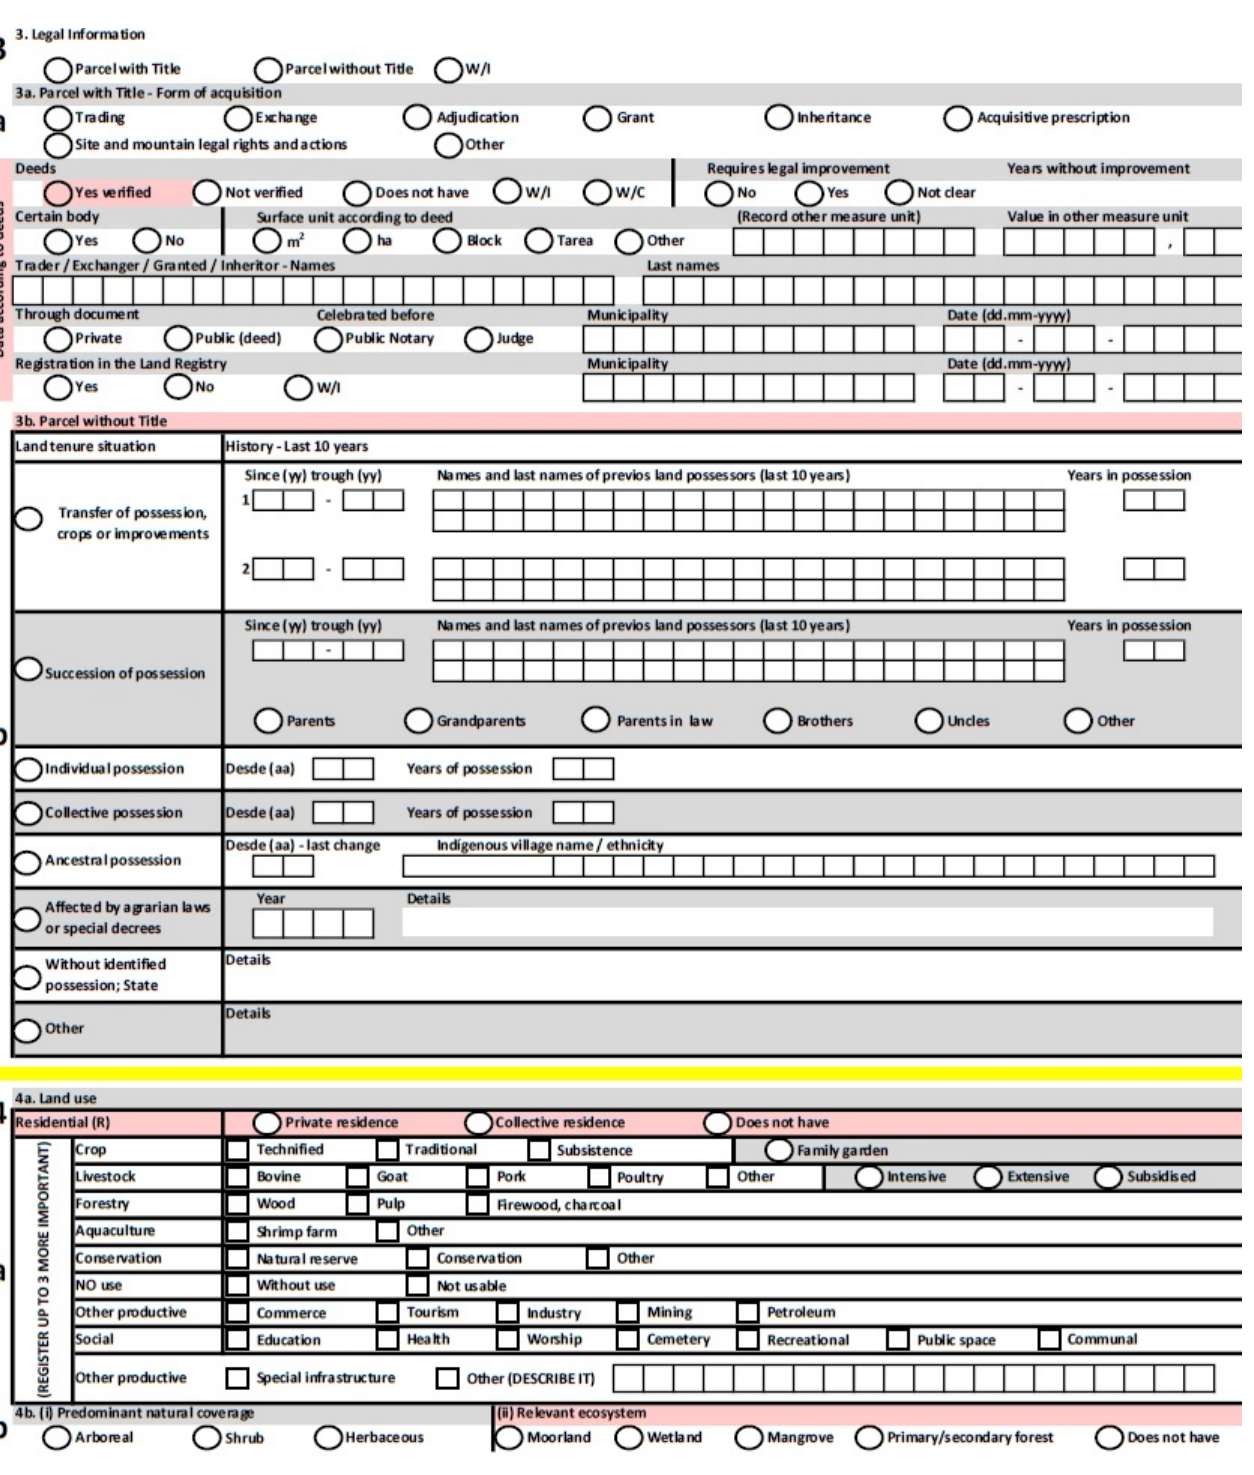
Figure A1. Fieldwork form for rural land survey textual data collection. Source: SIGTERRAS—secondary data collected during fieldwork.